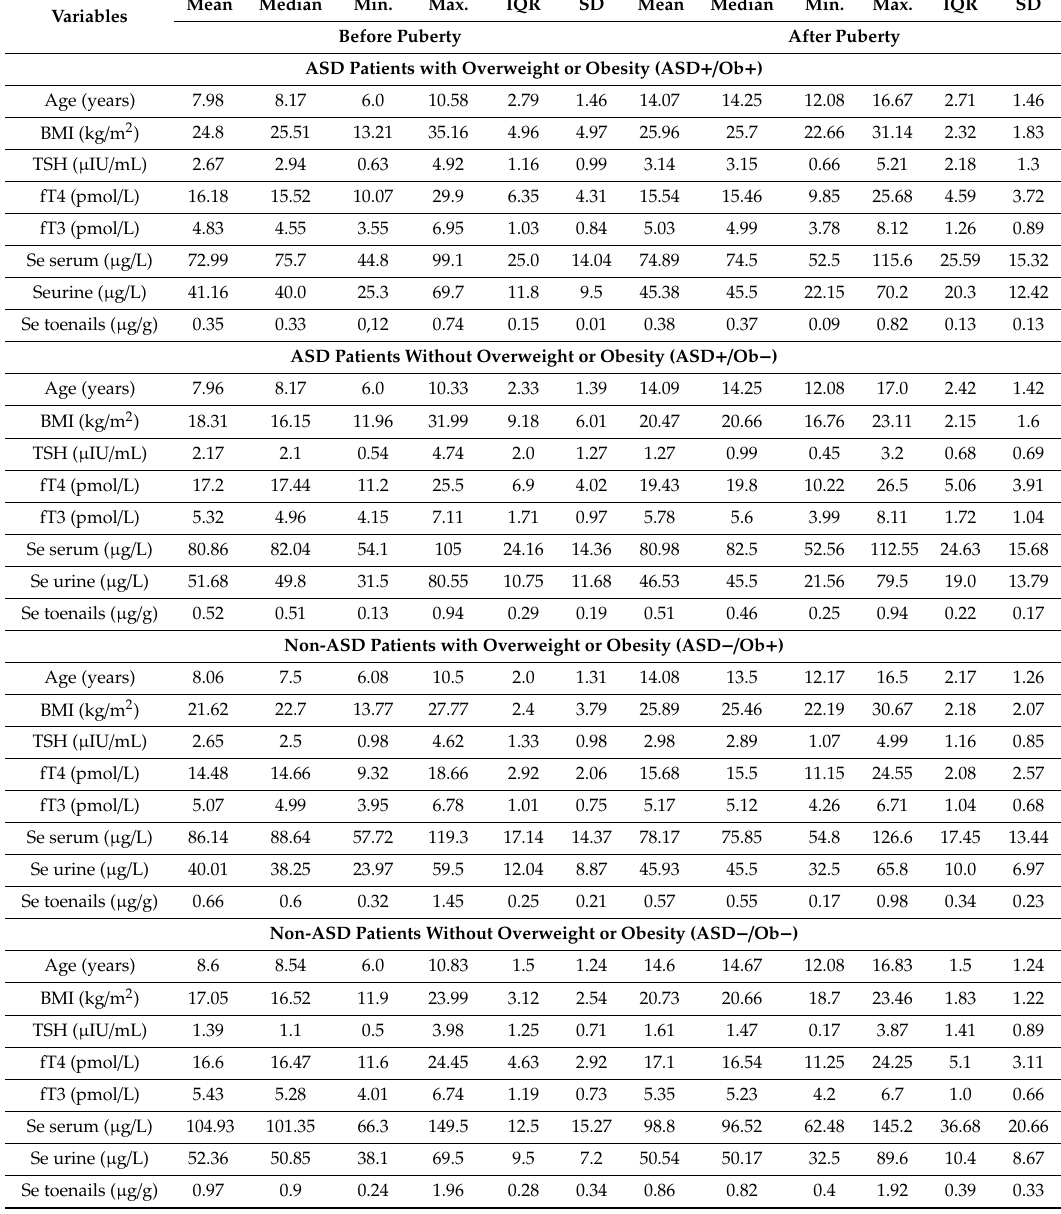
Table 1. Characteristics of pre- and post-pubertal